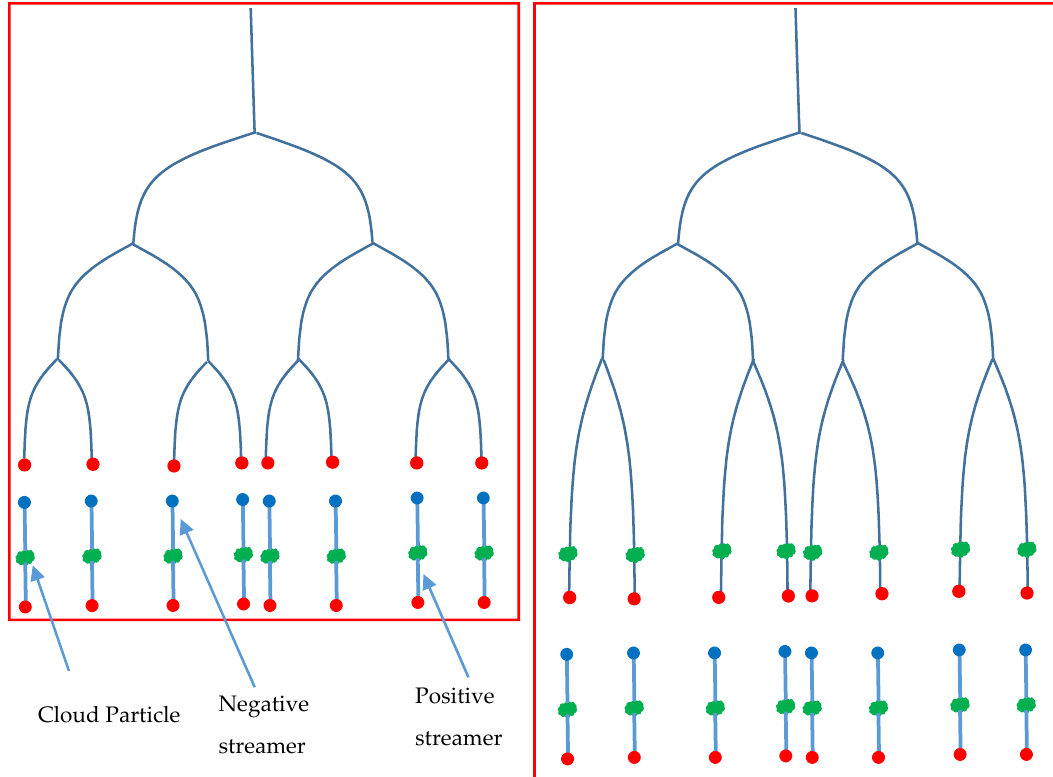
Figure 19. Schematic representation of the cloud particle assisted streamer propagation. As the streamer front moves, the electric field ahead of the streamer front causes the cloud particles located ahead of the streamer front to generate bi-directional streamers (frame to the left). The positive component of the bidirectional streamers will propagate ahead as the new front of the streamer burst while the negative counterpart of the bidirectional streamer neutralizes the positive charge of the previous front (frame to the right). The process is repeated continuously allowing the streamer burst to move rapidly.